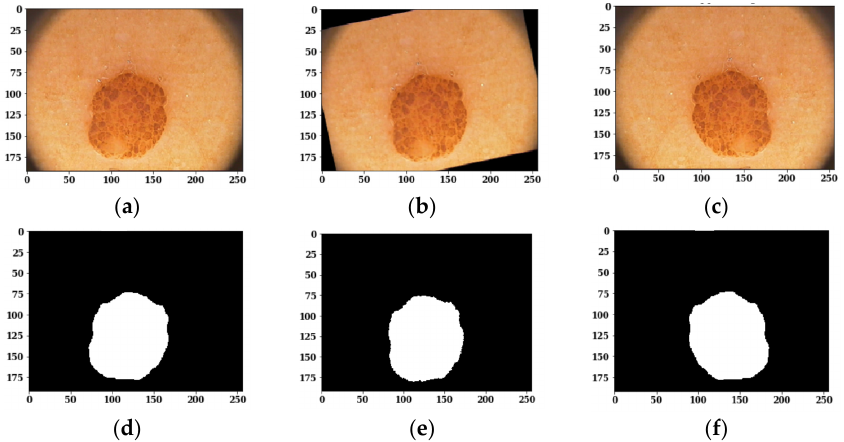
Figure 3. Images and Respective Masks after Data Augmentation Techniques: ( a ) Original Image; ( b ) Rotated Image; ( c ) Flipped Image; ( d ) Original Mask; ( e ) Rotated Mask; ( f ) Flipped Mask.